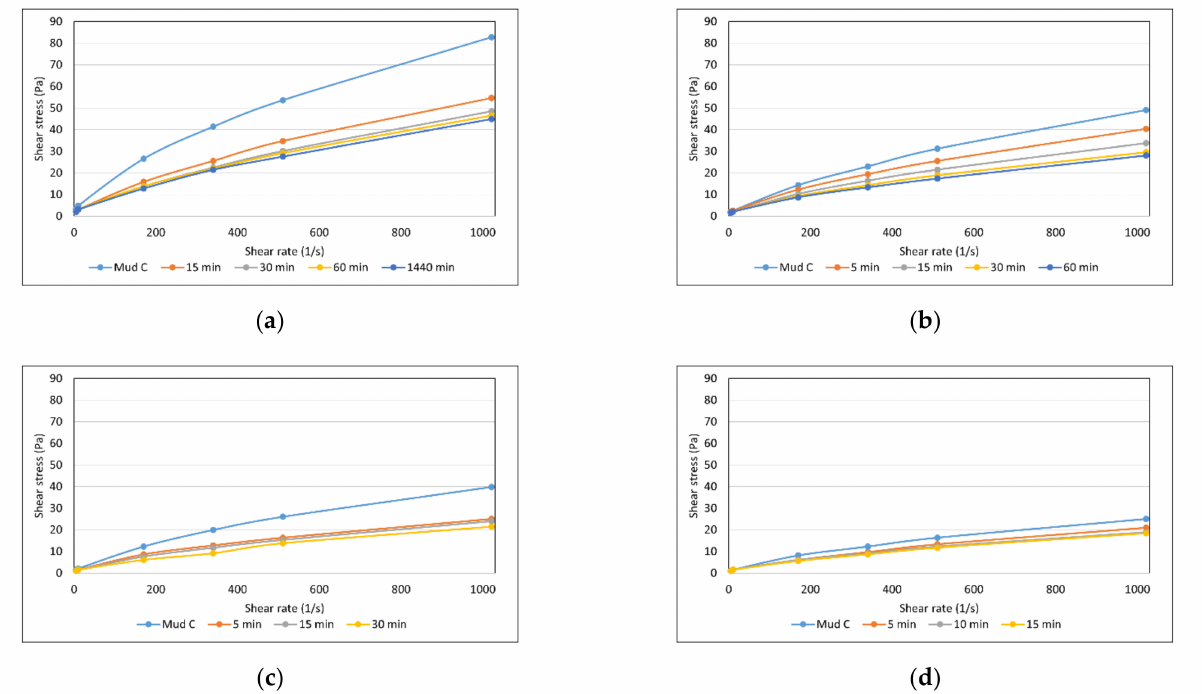
Figure 10. Flow curves of drilling mud C with the addition of 1.0% sodium persulfate: ( a ) at 20 ◦ C, ( b ) at 40 ◦ C, ( c ) at 60 ◦ C, ( d ) at 80 ◦ C.